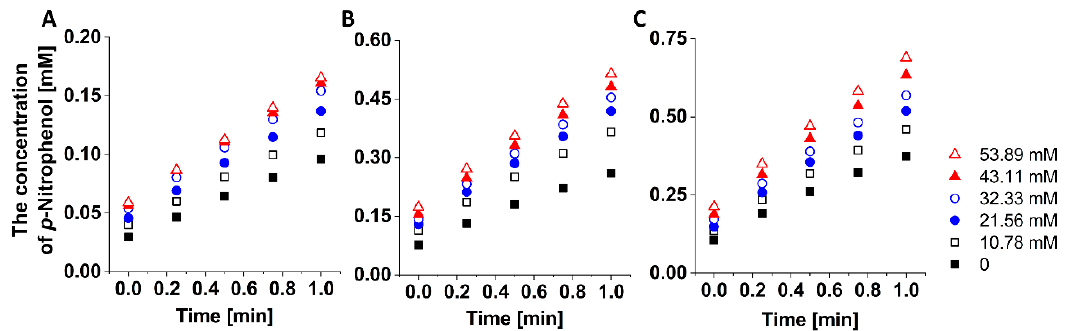
Micromachines 2019 , 10 , x